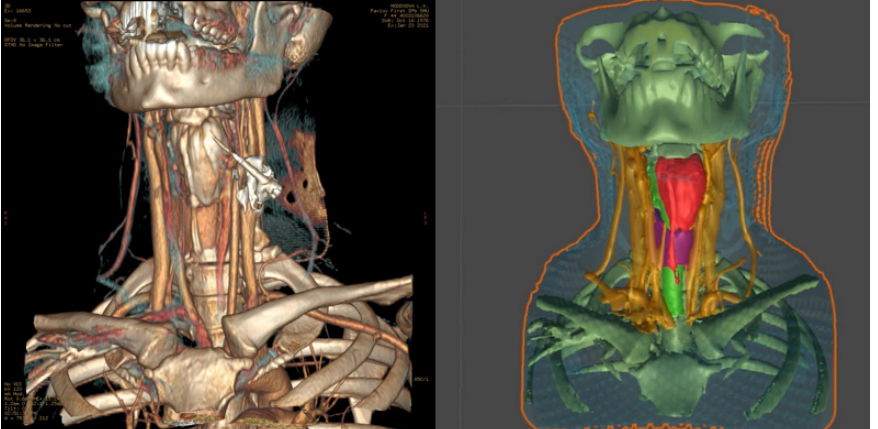
Figure 3. Three-dimensional reconstruction ( left ) [21] and a 3D model built using the segmentation method in the 3D Slicer ( right ). The contrast media allowed for the visualization of the cyst with the double-blind fistula, which ends at the lower edge of the isthmus of thyroid gland).